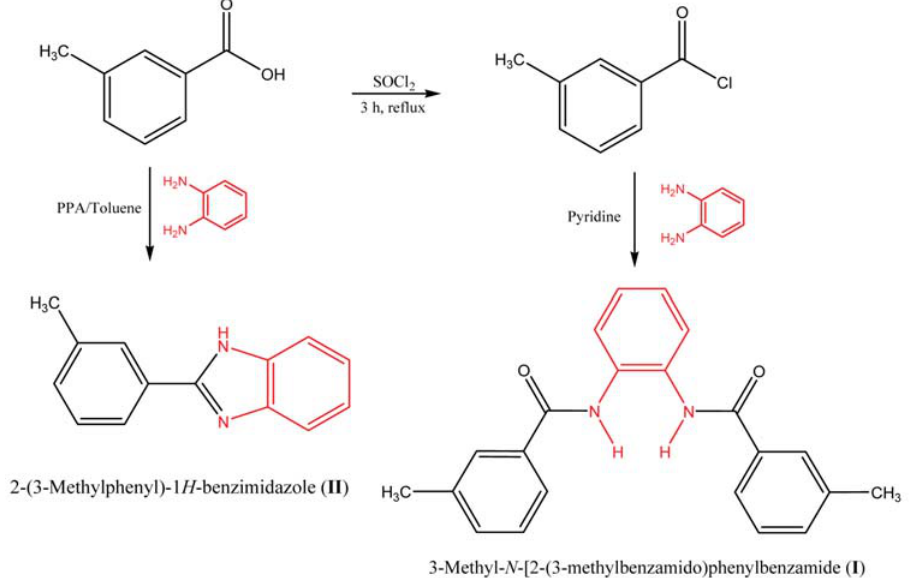
Figure 1. A synthesis scheme of 3-methyl- N - [ 2-(3-methylbenzamido)phenylbenzamide ( I) and 2-(3-methylphenyl)-1 H -benzimidazole ( II